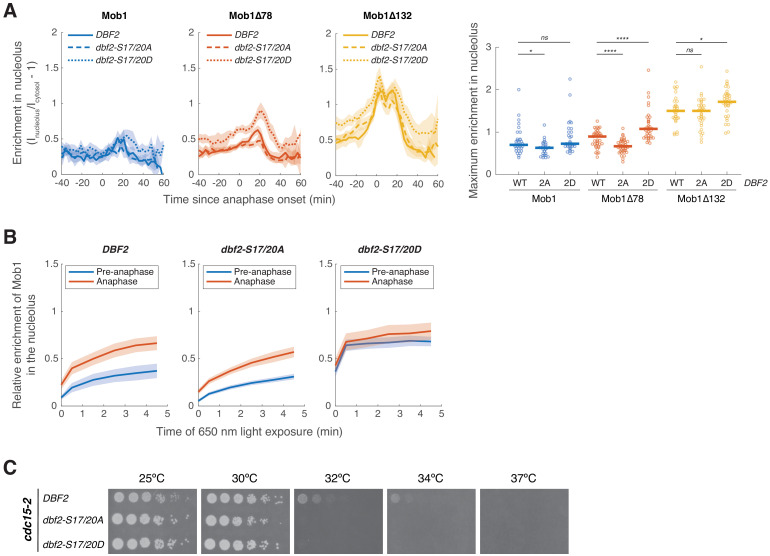
Phosphorylation of Dbf2’s nuclear export signal (NES) partially regulates Dbf2-Mob1’s nuclear access.(A) Nucleolar enrichment of full-length and truncated Mob1 in wild-type DBF2, dbf2-S17/20A or dbf2-S17/20D cells (A41614, A41617, A41620, A41615, A41618, A41621, A41616, A41619, A41622; n = 32, 28, 33,39, 43, 37, 31, 35, and 37 cells respectively). Cells were grown and imaged as in Figure 1E. Solid lines represent the average; shaded areas represent 95% confidence intervals. For maximum enrichment, each dot represents a single cell. Solid lines represent the median. ****p<0.0001; *p<0.05 by two-sided Wilcoxon rank sum test. (B) Enrichment of Mob1 in the nucleolus as a function of PhyB activation time for cells expressing wild-type DBF2 (A41608; n = 42 and 24 cells for pre-anaphase and anaphase, respectively), dbf2-S17/20A (A41609; n = 55 and 41 cells for pre-anaphase and anaphase, respectively) or dbf2-S17/20D (A41610; n = 58 and 28 cells for pre-anaphase and anaphase, respectively). Cells were grown as in Figure 3—figure supplement 1. (C) Fivefold serial dilutions of cdc15-2 cells harboring wild-type DBF2 (A41624), dbf2-S17/20A (A41625), or dbf2-S17/20D (A41626) in YEP + 2% glucose at the indicated temperatures.